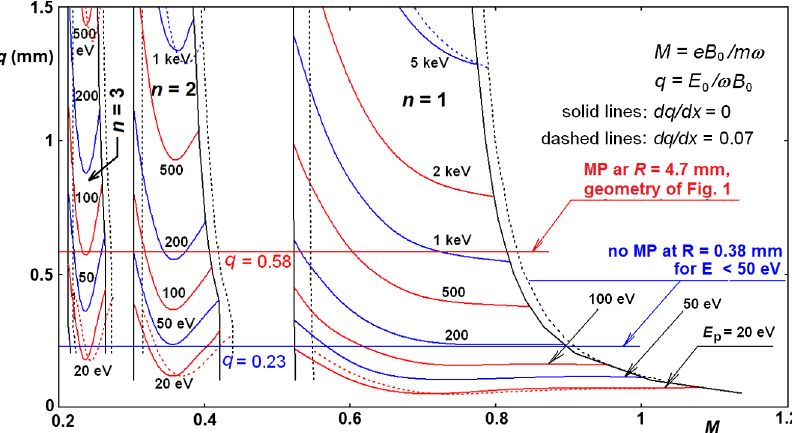
FIG. 9. First three zones of MP1 with dq=dx ¼ 0 and dq=dx ¼ 0 : 07 . Emission energy of secondary electrons E s ¼ 4 eV , E p is the impact energy of primary electrons.